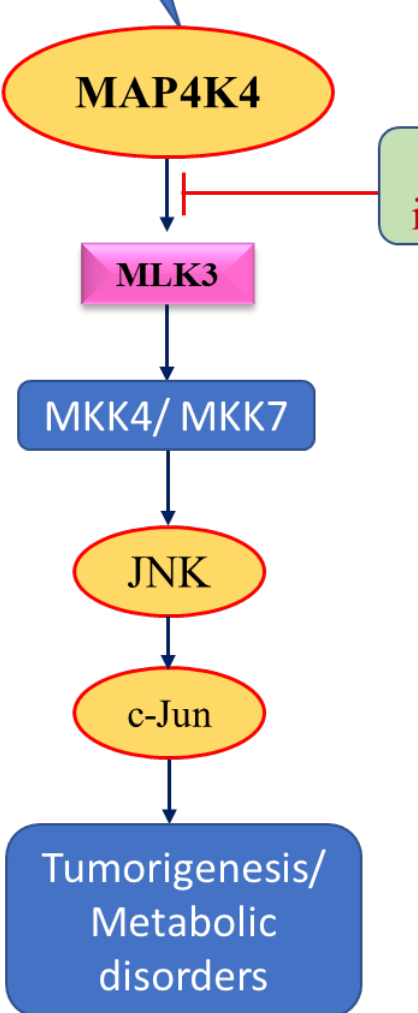
Figure 4. Schematic diagram showing therapeutic targets. Targeting MAPK signaling using inhibitors at specific sites to treat cancer and metabolic disorders and enhance patient survival.